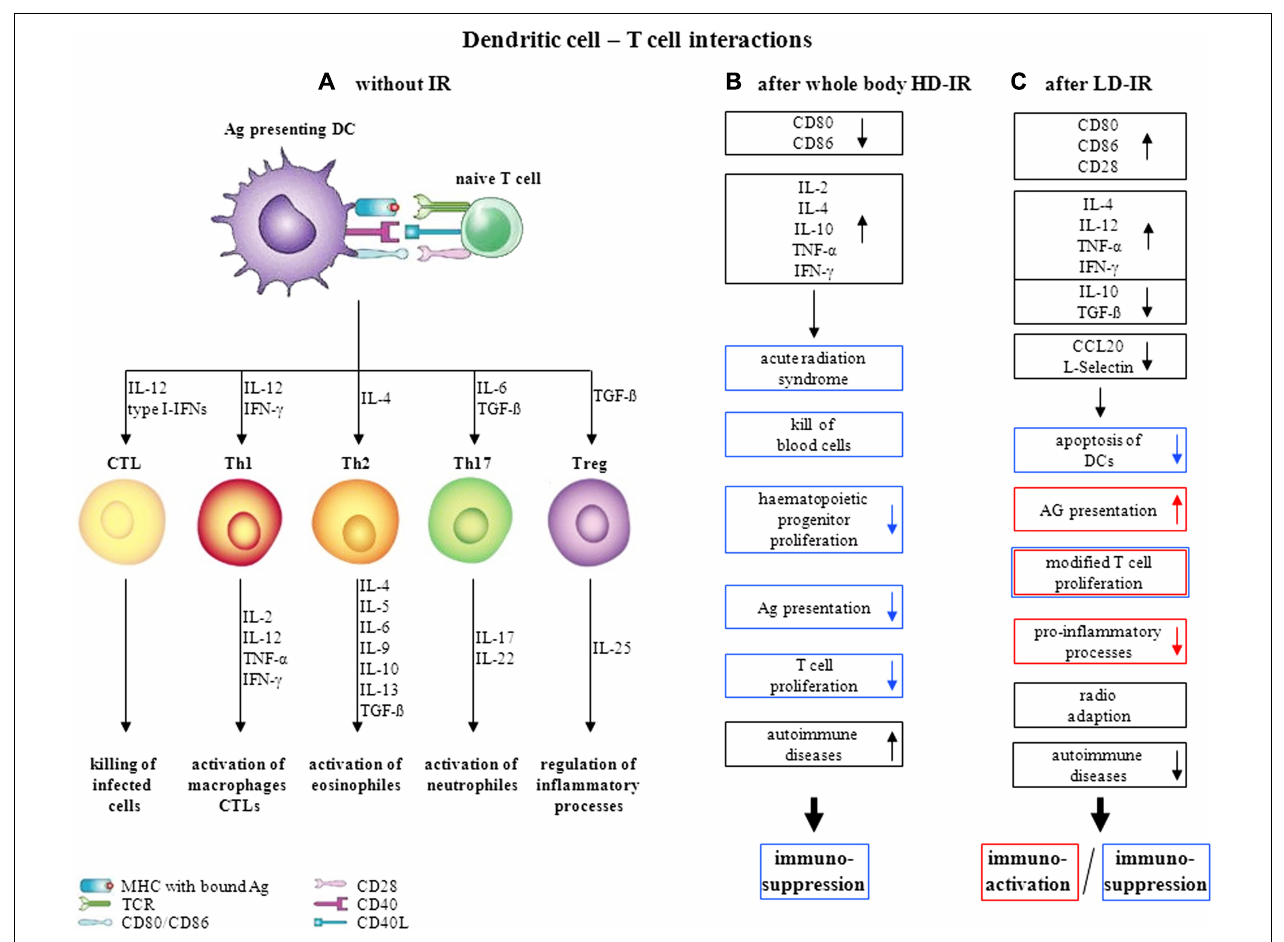
FIGURE 1 | Dendritic cell–T cell interactions and its variations upon irradiation, (A) without irradiation (modified after Moser and Leo, 2010), (B) influence of whole-body HD-IR, (C) influence of